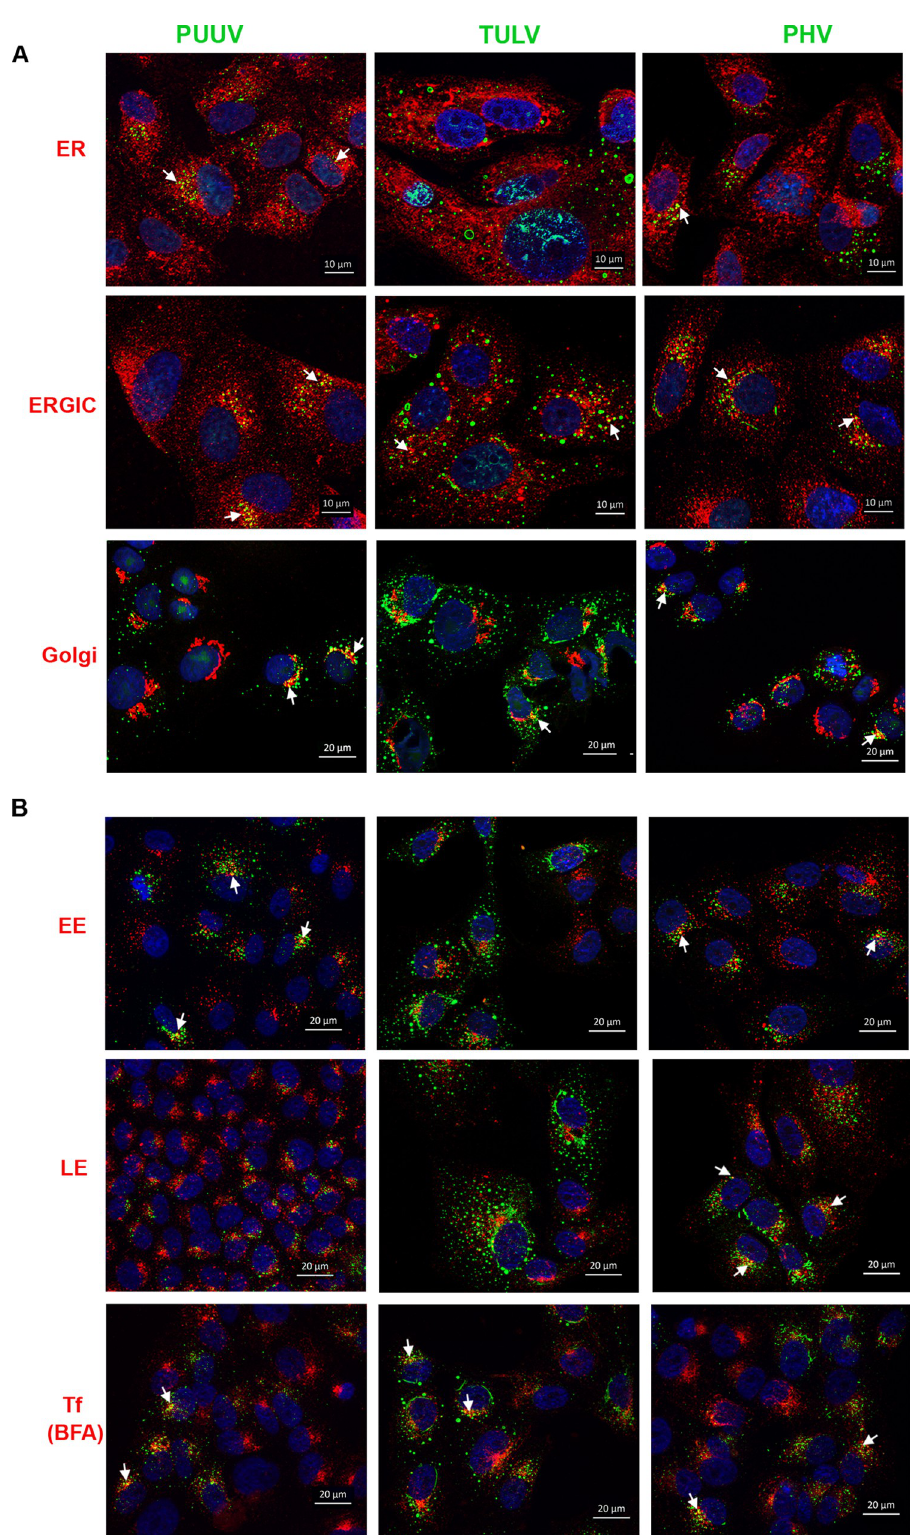
Fig 4. Distribution of N proteins relative to cellular compartments. Vero E6 cells grown on glass coverslip were infected with PUUV, TULV or PHV at MOI 1. Intracellular co-localization appeared in yellow in the merge